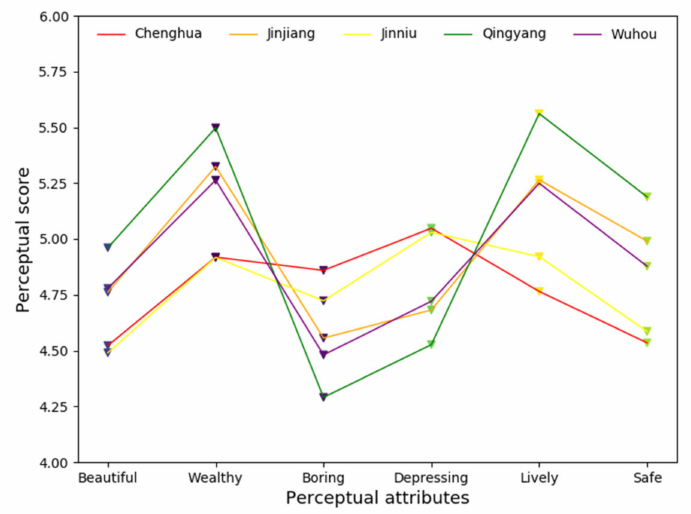
Figure 15. The perceptual result with six attributes of each administrative district in Chengdu.